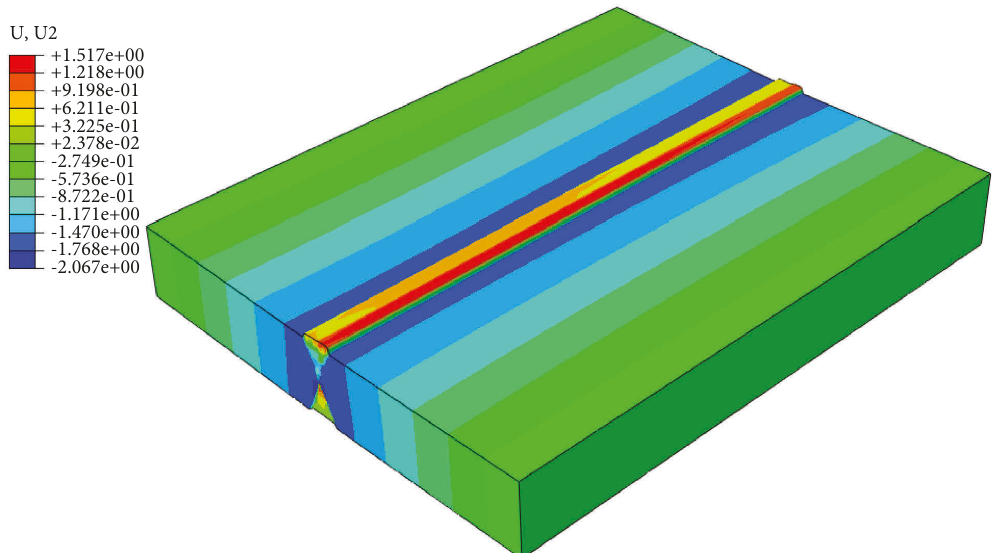
Figure 11: Distribution of the vertical deformation.